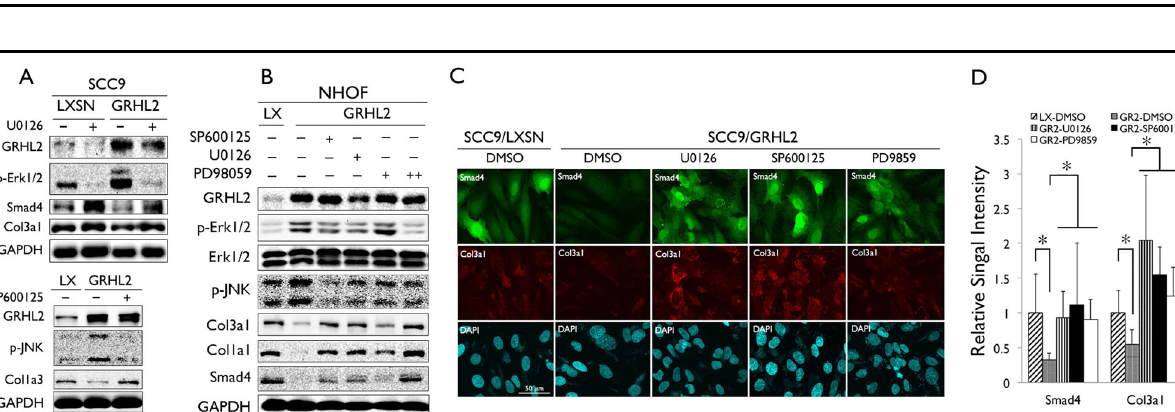
Fig. 6 GRHL2 regulates Erk and JNK activation in OSCC cells. a In SCC4 and SCC15 cell lines with GRHL2 knockdown, western blotting was performed for p-Erk1/2, p-JNK, p-p38, and p-p65. b SCC4 and SCC15 cells with GRHL2 knockdown (ShGRHL2) and the control cells (ShContr) were fractionated into cytoplasmic and nuclear fractions, and western blotting was performed for p-Erk1/2 and p-p65. p84 was used as marker for nuclear fraction, while GAPDH was used as cytoplasmic loading control. c , d Tongue epithelium from Grhl2 WT and KO mice exposed to 4-NQO for 16 weeks was stained for p-Erk1/2, p-JNK, and Smad4 by IHC. IHC-positive cells were counted in each fi eld and plotted as % of all cells. Bar indicates mean/SD. * P o 0.05, statistical signi fi cance, compared with WT mice